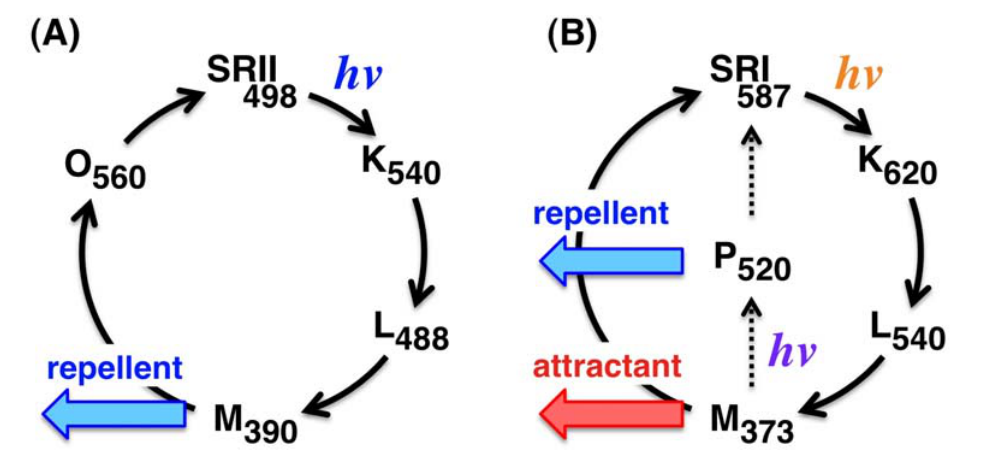
Figure 2. Photochemical reaction cycles of SRII (A) and SRI (B). SRII absorbs blue light ), L (L ), M (M ), and O (O ) intermediates [53]. The M and O and forms K (K 540 488 390 560 intermediates are thought to be active states. SRI absorbs orange light and forms K (K ) and the long-lived M intermediates (M ), which forms the P intermediate (P L (L 540 373 upon the second photon absorption in the near-UV region